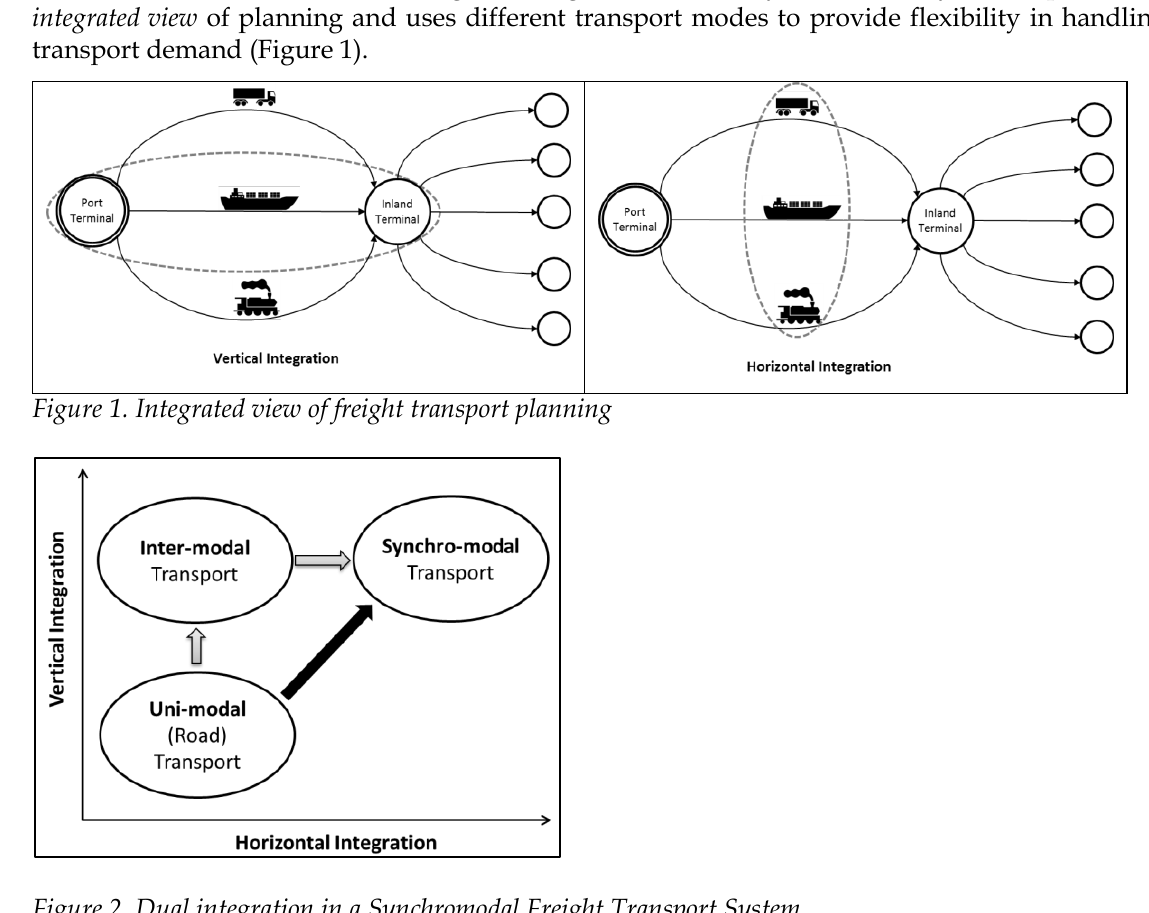
Figure 2. Dual integration in a Synchromodal Freight Transport